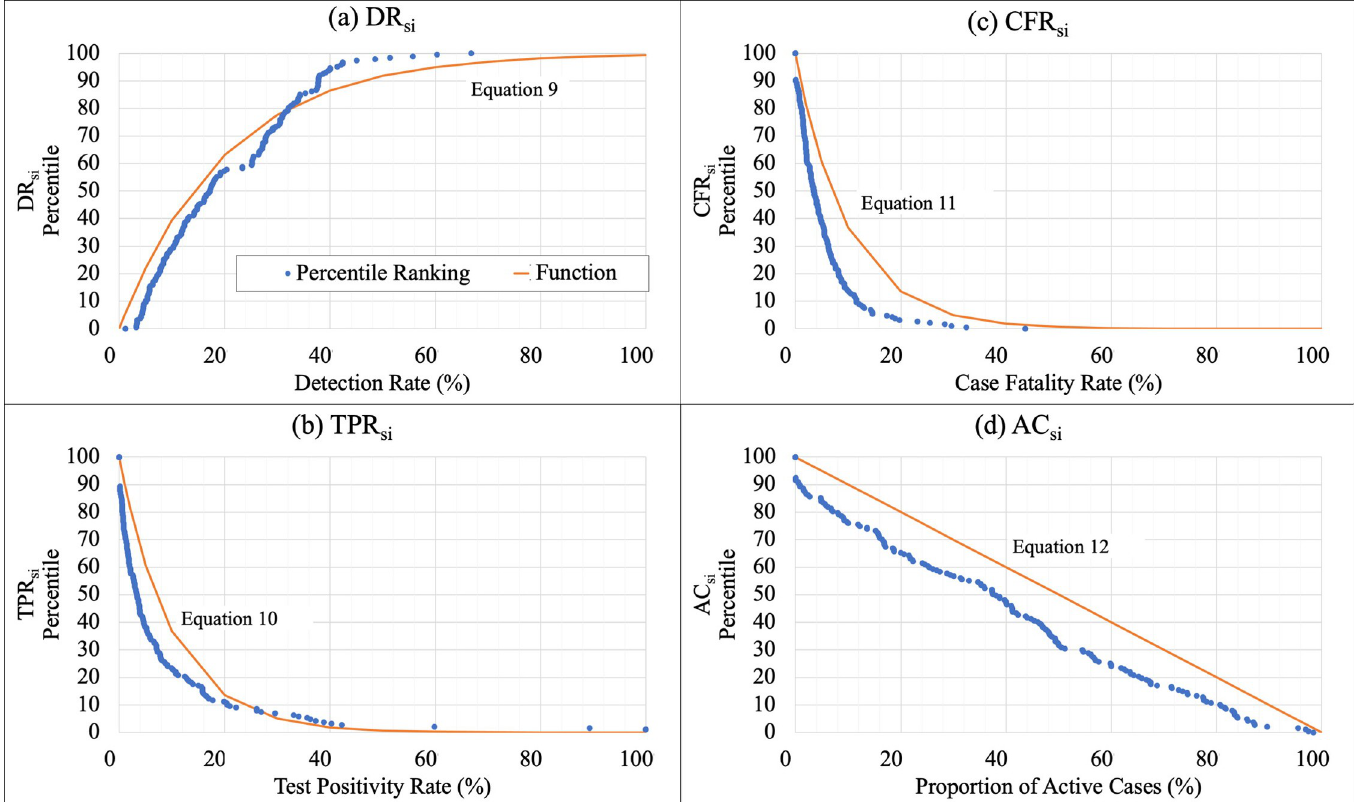
Fig 2. Percentile rankings and sub-index functions for four key indicators. Percentile rankings, in which 100 represented to most desirable value of the indicator and 0 the least desirable, were computed for each of the four key indicators (a) DR, (b) TPR, (c) CFR, and (d) AC. Functions were fitted to the percentile ranks, which were used to compute the sub-indices (a) DR si , (b) TPR si , (c) CFR si , (d) AC si (Eqs 9–12).